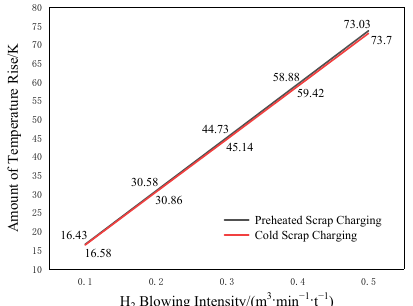
Figure 6. Effect of hydrogen bottom blowing at different intensities on the temperature of the molten pool.